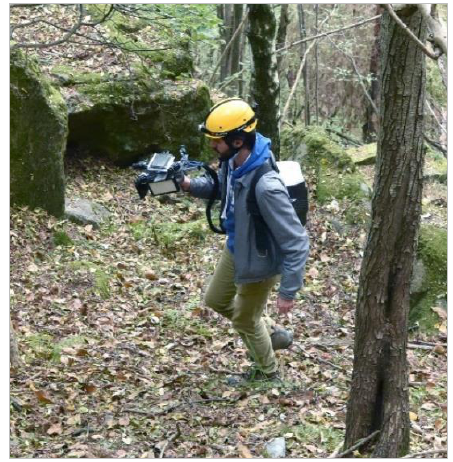
Figure 4 . Ant3D multicamera system during the on-field acquisitions.